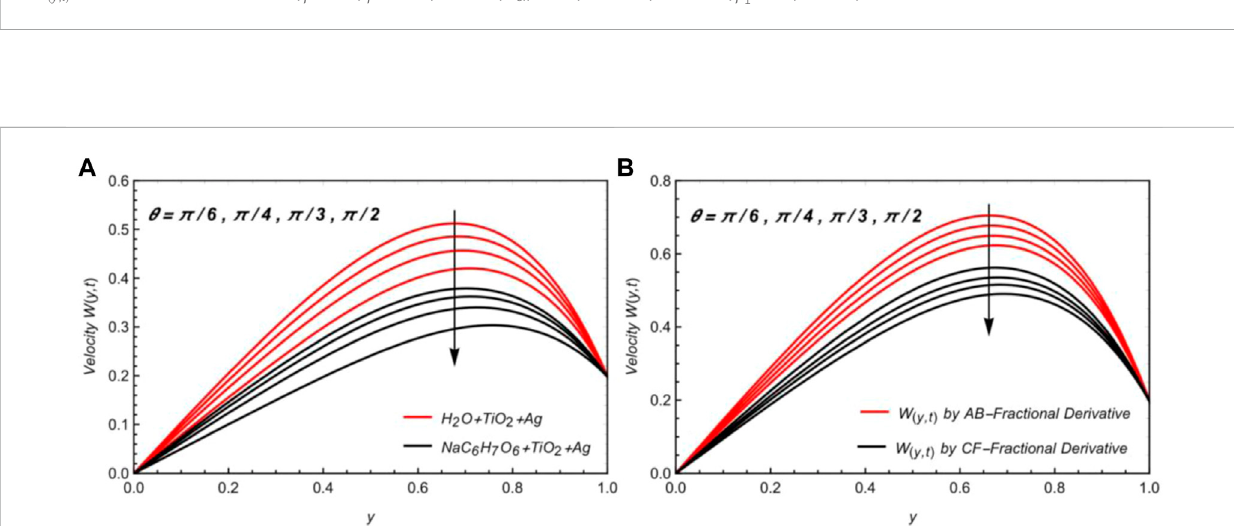
FIGURE 9 W ( y , t ) due to variation in M with α , β (cid:2) 0 . 5 , φ (cid:2) 0 . 02 , Ra (cid:2) 1 . 2 , K eff (cid:2) 0 . 7 , Gr (cid:2) 8 . 0 , Gm (cid:2) 6 . 3 , β 1 (cid:2) 1 . 5 , θ (cid:2) π /4 , and t (cid:2) 0 . 8.